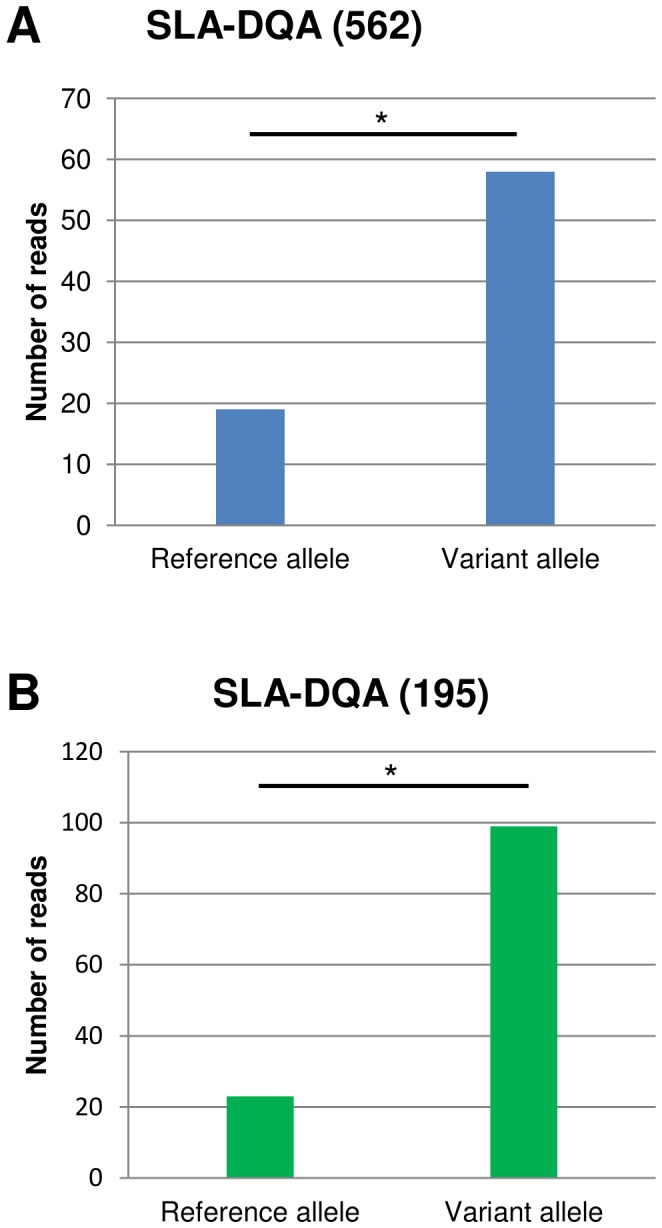
Allele-specific expression at two poly-miRTSs in SLA-DQA.RNA-Seq reads were obtained from alveolar macrophages (A) and whole blood (B) libraries. The asterisk indicates a significant difference between reads bearing the reference and the variant alleles assessed by a binomial test, p-value <0.001.